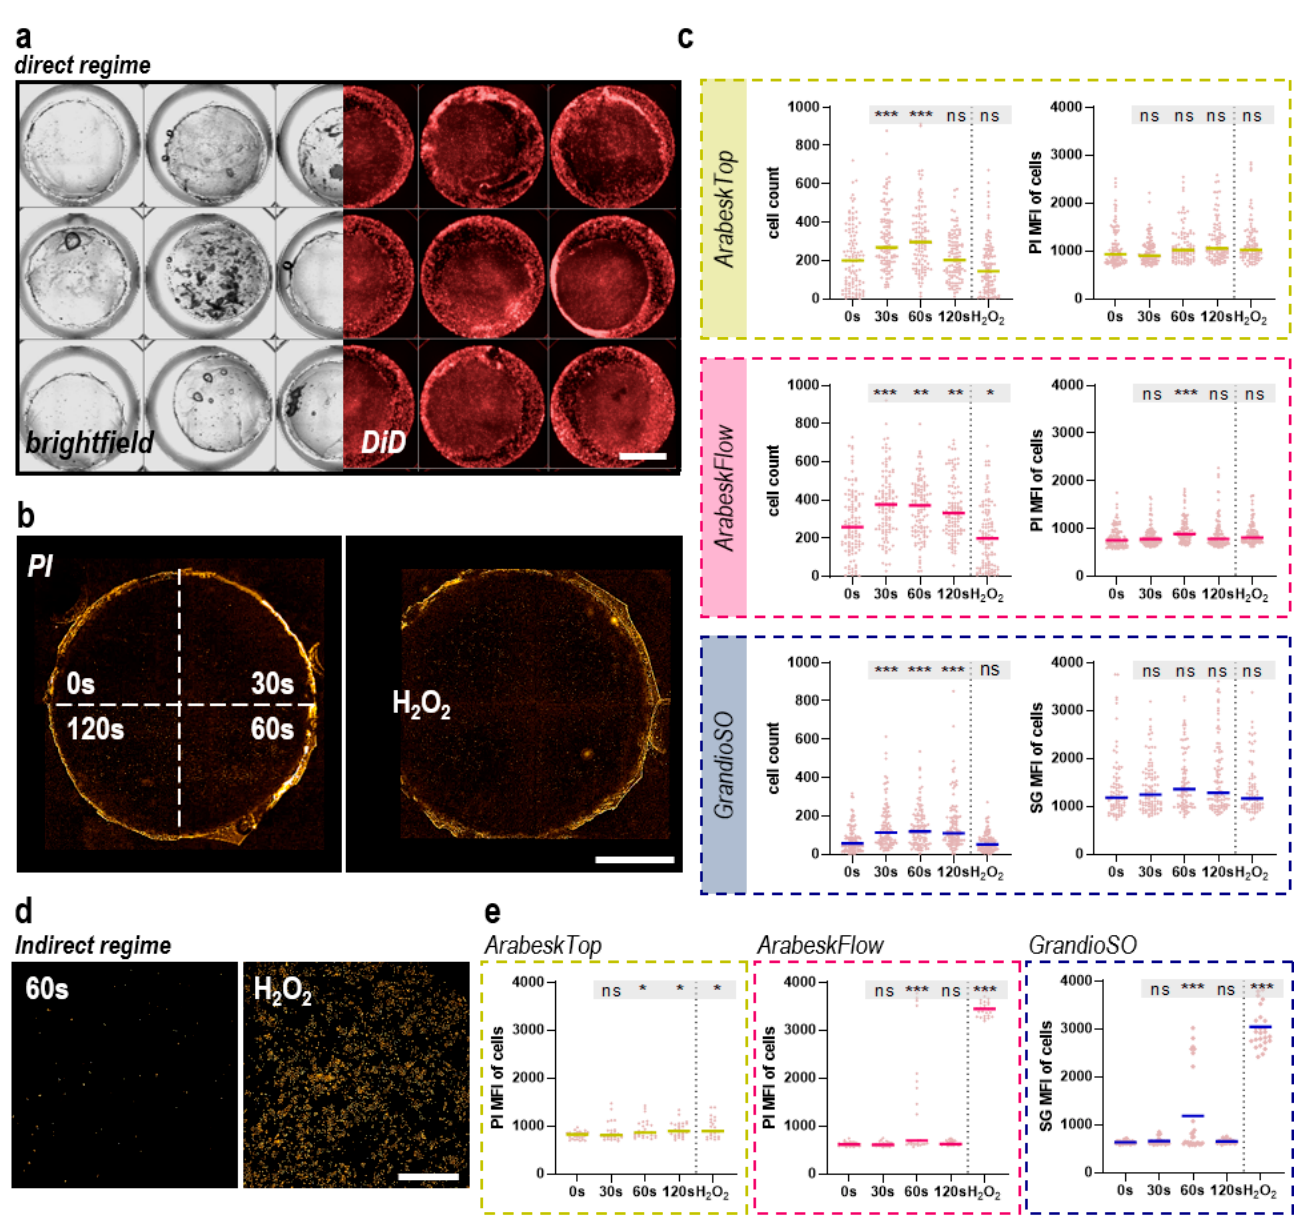
Figure 3. Quantitative fluorescence imaging. ( a ) brightfield (left) and fluorescently labeled (DiD) human HaCaT keratinocytes grown on composite chips cultured in a tissue culture-treated 96-well plate with each well image being digitally stitched from nine individual fields of view with three channels (brightfield, DiD, PI) each; ( b ) representative PI imaged digitally aligned side-by-side for all gas plasma treatment conditions (in the experiments, each composite chip was exposed to a single gas plasma treatment time) of composite chips and the positive control H 2 O 2 ; ( c ) quantitative algorithm-driven image analysis of the number of cells (left) and mean fluorescence intensity (MFI) of PI per cell and well (right) across the three composite chip types investigated in this study of the direct treatment and culture regimen; ( d ) representative PI images of a 60 s gas plasma-treated (left) and H 2 O 2 -treated (right) composite chips; ( e ) quantitative algorithm-driven image analysis of the number of cells (left) and mean PI intensity per cell and well (right) across the three composite chip types investigated in this study of the indirect treatment and culture regimen. Data are mean of four independent experiments with three technical replicates and several fields of view each. Statistical analysis was performed using one-way analysis of variances with * = p < 0.05, ** = p < 0.01, and *** = p < 0.001 and the Dunnett post-hoc test for untreated control conditions (0